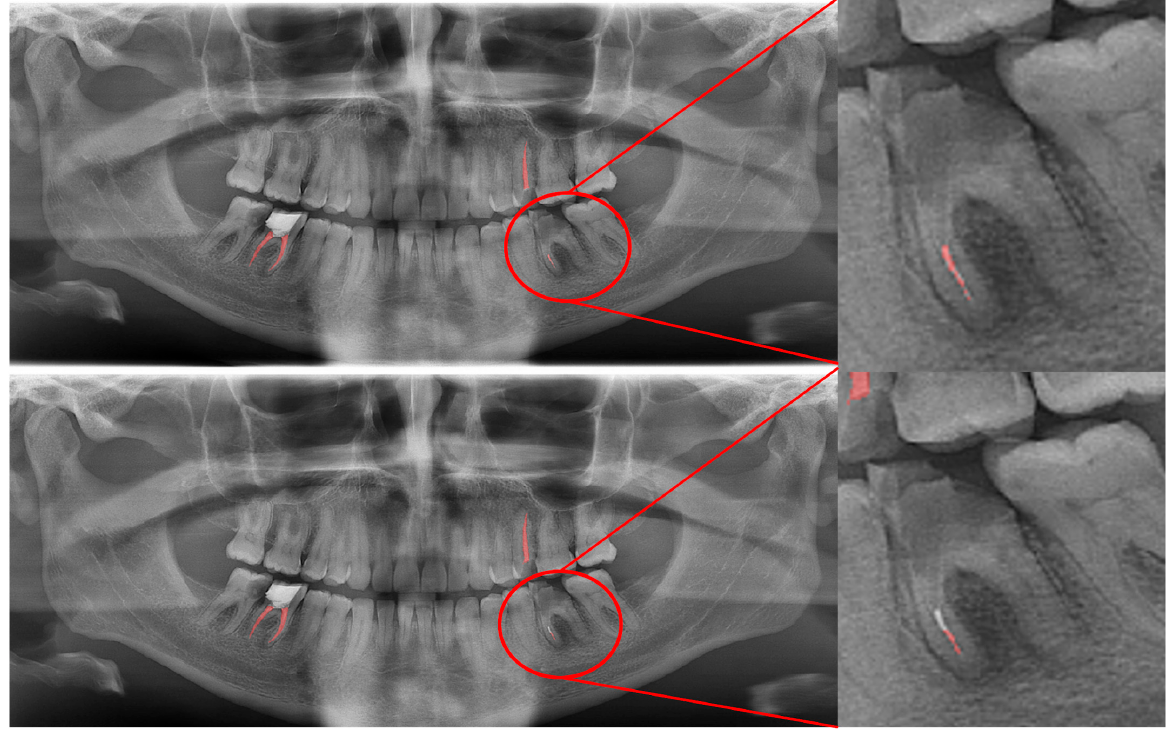
Figure 12. Imperfect segmentation of a gutta-percha is seen at the mandibular left first molar tooth’s mesial root. Manual segmentation (upper image) and automatic segmentation (lower image) can be seen above.